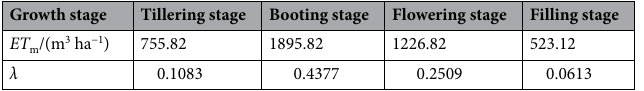
Table 8. Basic parameters of irrigation system